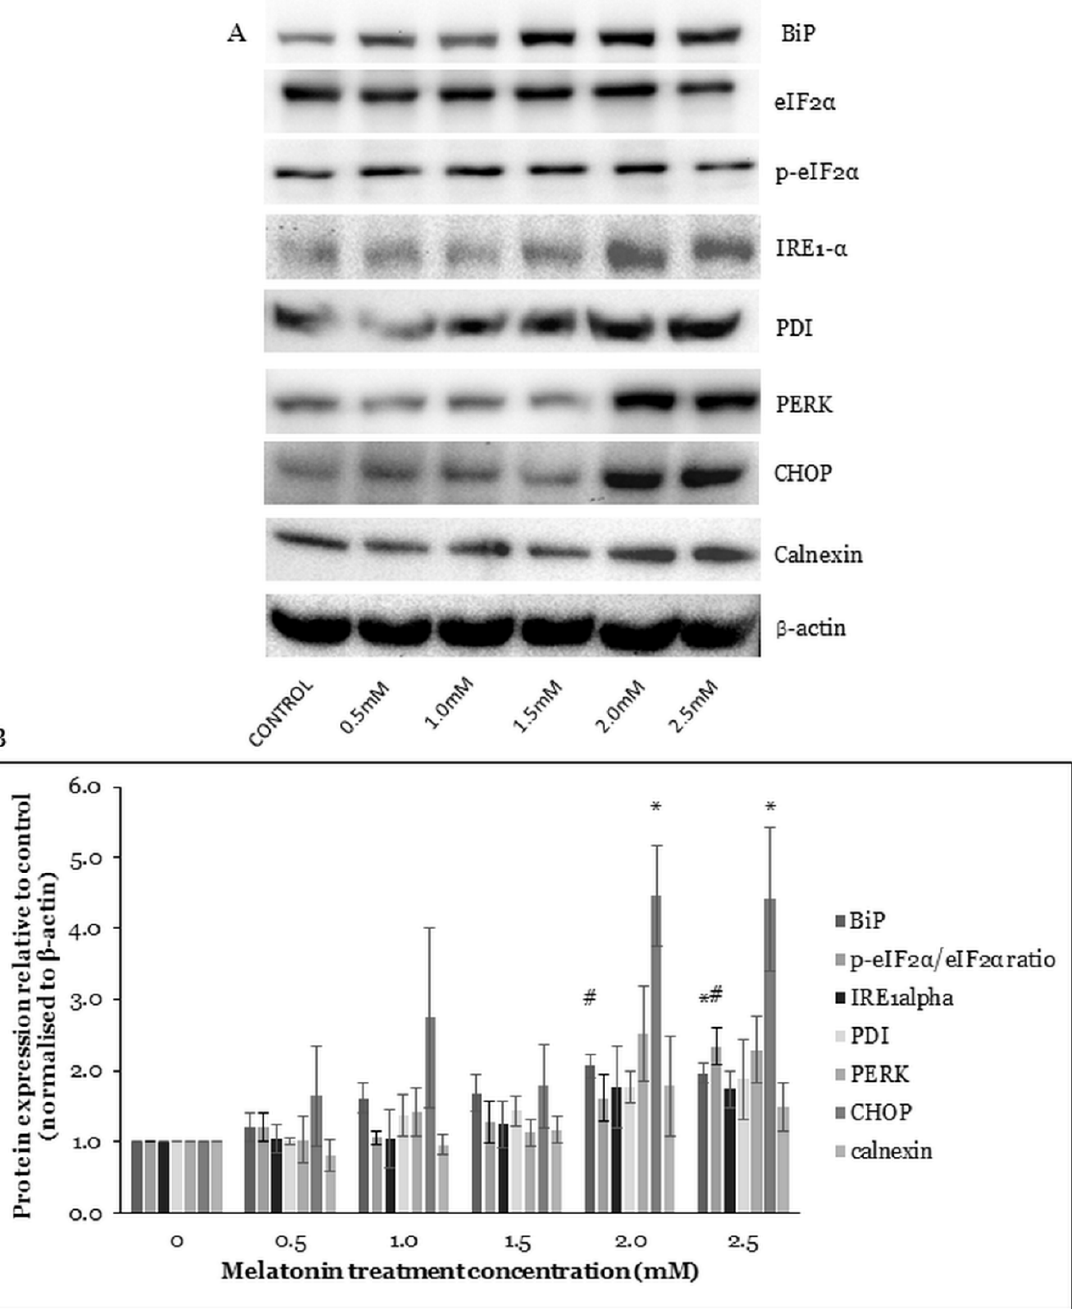
Figure 4. Western blot analysis of the ER stress in HT-29 cells after treated with various concentrations of melatonin for 72 h. ( A ) Expression levels of ER stress-related proteins were measured by Western blot analysis. Beta-actin ( β -actin) served as a loading control. ( B ) Bar chart of the protein expressions; each bar represents a mean ± SEM of three independent experiments. One-way ANOVA, followed by Dunnett’s post hoc test, was performed to compare each treatment group with control; statistically significantly different from control: *, p < 0.05; #, p < 0.01.